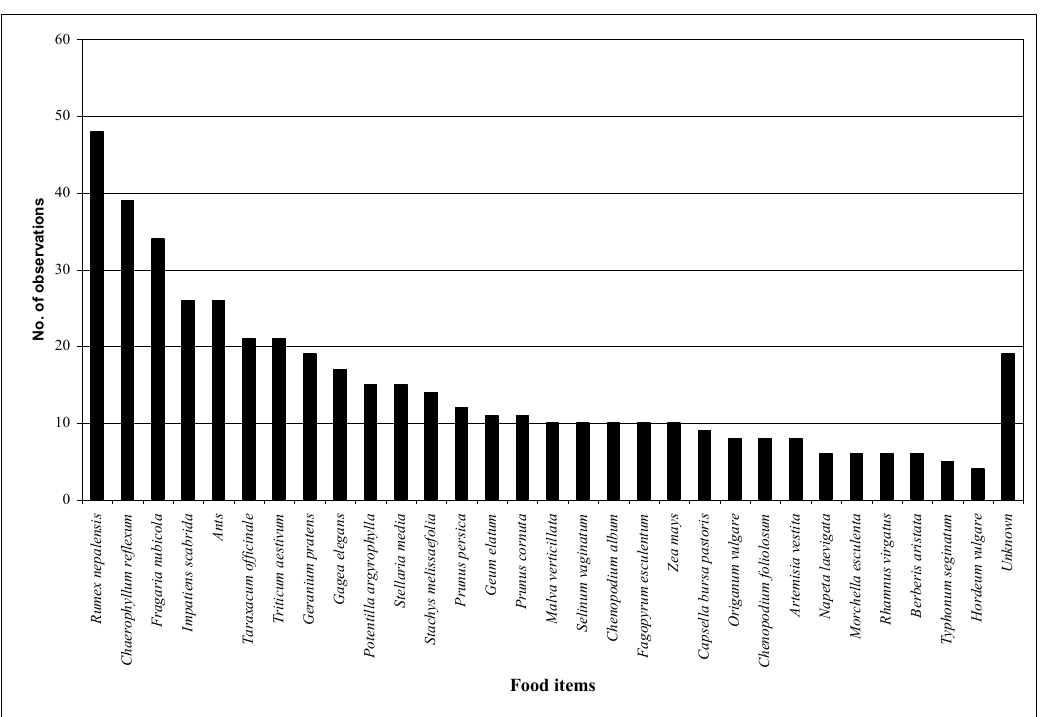
Figure 5. Number of direct feeding observations on food plants by Himalayan Brown Bear in Kugti Wildlife Sanctuary during 2002–2004.